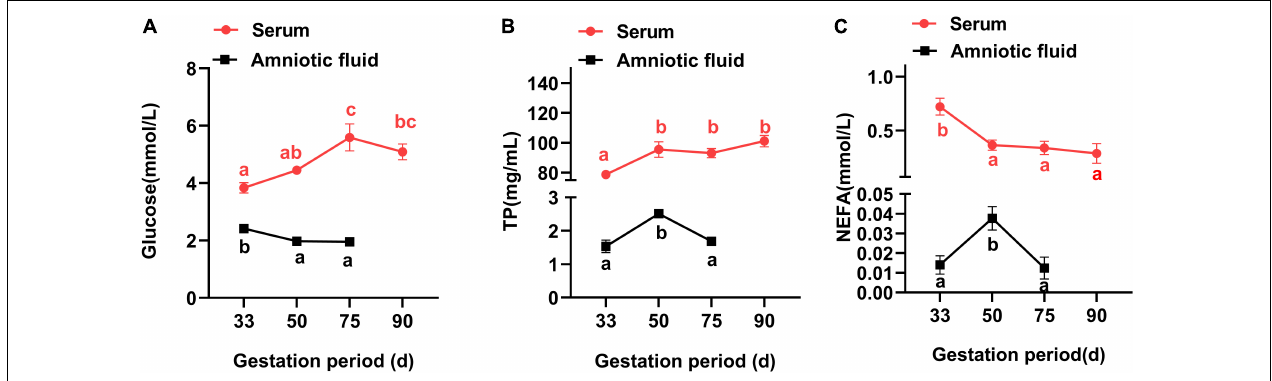
FIGURE 1 | Changes of biochemical parameters in the serum and amniotic fluid of Tibetan sows at different gestation periods. (A) Glucose; (B) TP; and (C) NEFA. Data are expressed as mean ± SEM ( N = 3). TP, total protein; NEFA, non-esterified fatty acids. Different lowercase letters represent significant difference at P < 0.05.